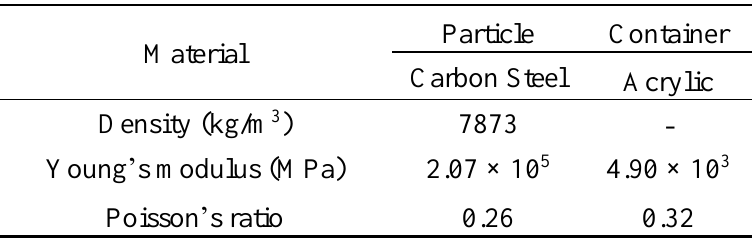
Table 1. Material